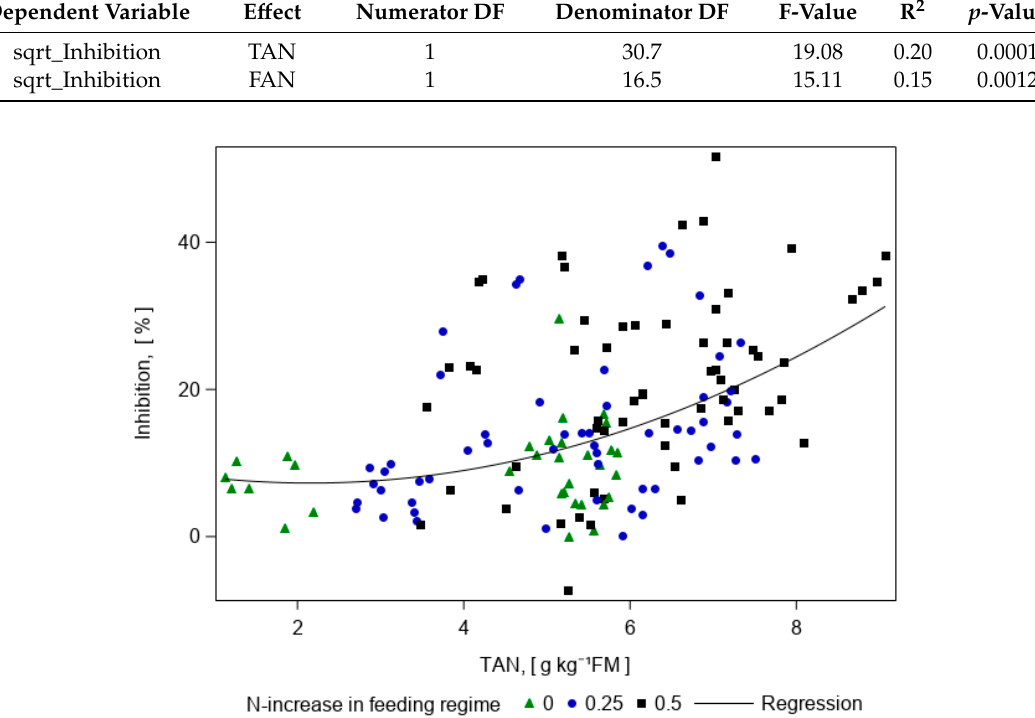
Figure 4. The correlation between the total ammonia nitrogen (TAN) and the inhibition in specific methane yield (Inhibition). The “0”, “0.25” and “0.5” marks in the legend correspond to the N-increase variants of “0-increase”, “0.25-increase” and “0.5-increase” in the feeding regimes. The regression line was built based on the results obtained from the model.